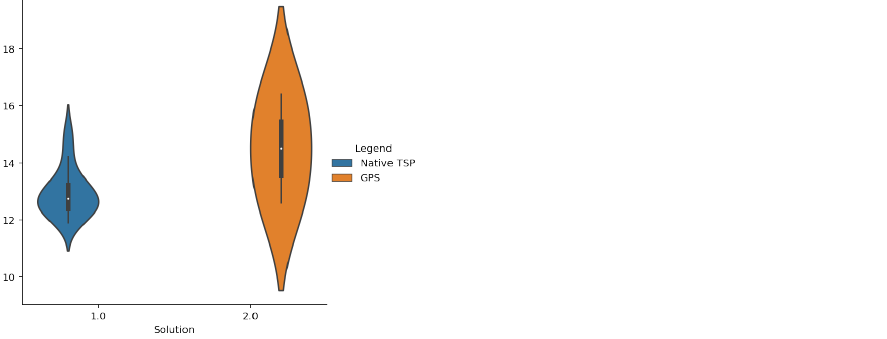
Figure 6. Path length comparison for N = 11. For the example of 11 cities, we can observe that the outcomes are quite similar. Although the time difference is not significant again, the difference between path lengths is. Let us remember that the advantage of the modelling we have worked is based on improving the number of qubits used. We then have that the larger the problems we are working on, the better that difference will be appreciated in the number of variables.